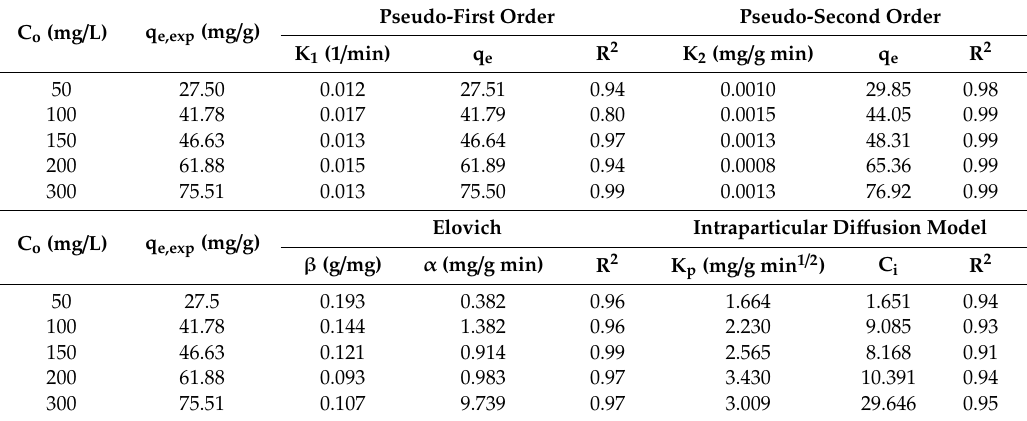
Table 2. Kinetic parameters of the models studied for 2,4-D on AC at di ff erent initial concentrations and 25 ◦ C.